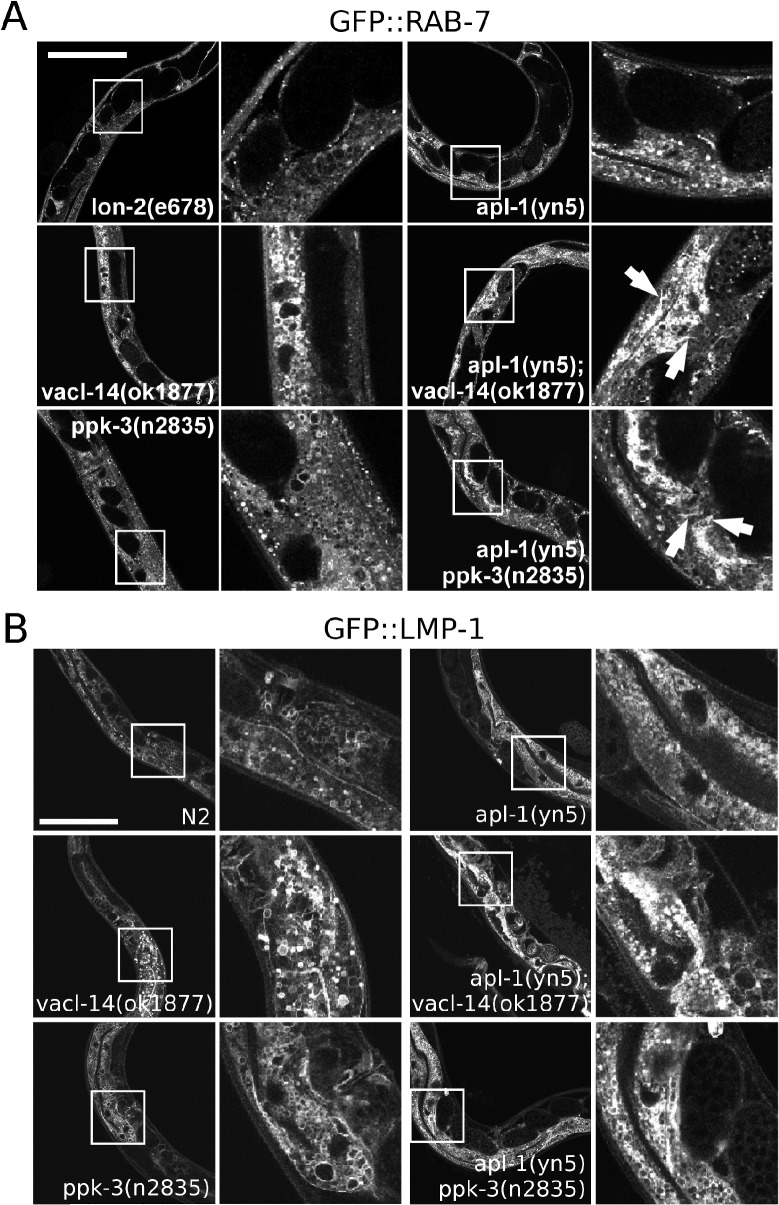
Mutations in apl-1 and ppk-3 or vacl-14 lead to defective processing of late endosomes and lysosomes in young adults.(A) In control animals and single apl-1(yn5), vacl-14(ok1877) and ppk-3(n2835) mutants late endosomes stained using GFP::RAB-7 as a marker were visible as vesicles or small vacuoles. Combination of the mutations in apl-1(yn5); vacl-14(ok1877) or apl-1(yn-5) ppk-3(n2835) double mutants led to a drastic alteration of the morphology of the late endosomal compartment, e.g. late endosomes became tubular and clustered in the hypoderm and intestine when comparing double with single mutants. While in single mutants individual compartments were abundant, they appeared 'squashed' and tubular in the double mutants (indicated by arrows). (B) Analysis of the lysosomal marker GFP::LMP-1 showed that in single apl-1(yn5), vacl-14(ok1877) and ppk-3(n2835) mutants distinct, LMP-1 positive vacuoles of variable sizes were apparent. However, in apl-1(yn5); vacl-14(ok1877) and apl-1(yn5) ppk-3(n2835) double mutants the LMP-1 positive structures appeared aggregated, mimicking the defect observed in GFP::RAB-7 worms, suggesting a defect in late endosomal and lysosomal trafficking. These data showed that APL-1 and the PPK-3 complex are required for late endosomal processing. Bar, 100μm.